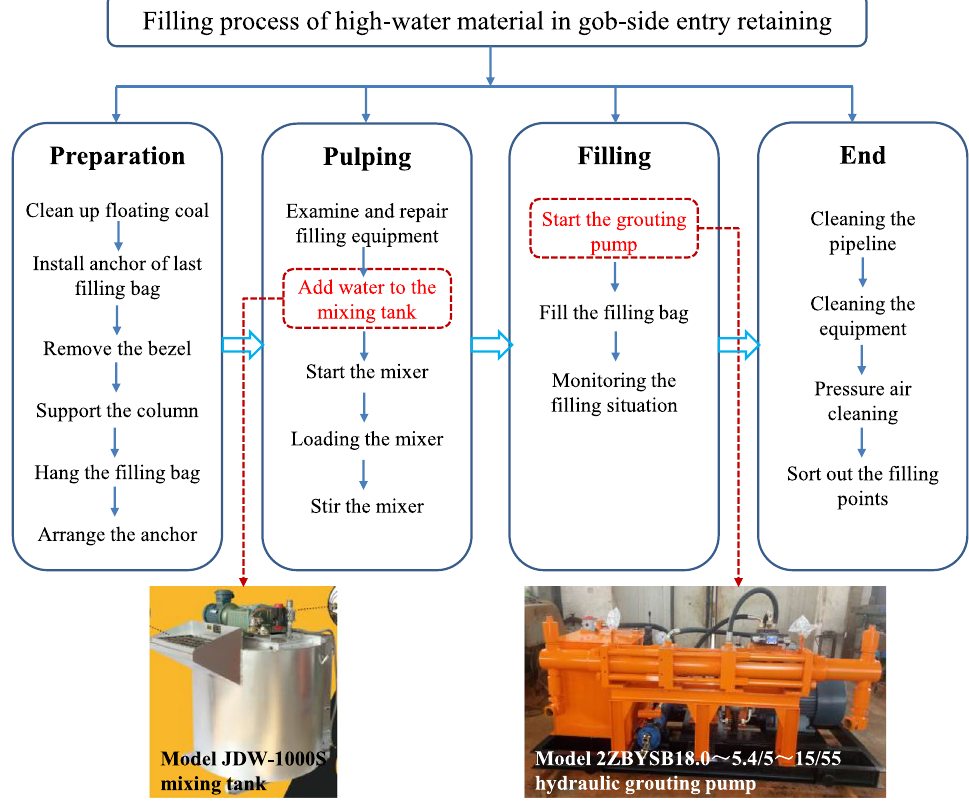
Fig. 12 Filling procedure for high-water material of